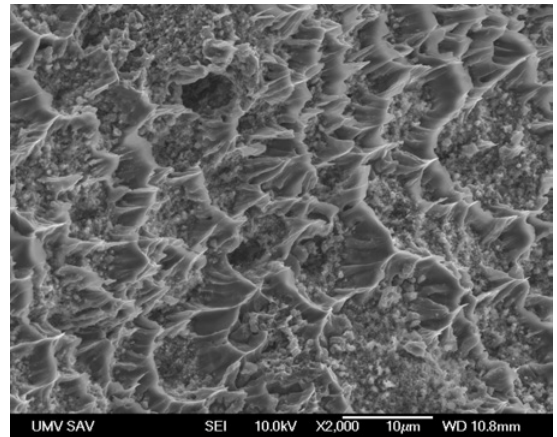
Figure 12. The fracture of Al-4 vol.% Al 4 C 3 after SP creep, direction 15°.